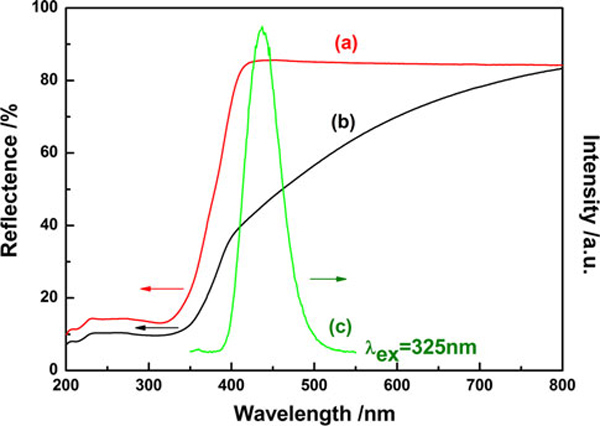
Overlap of diffuse reflectance spectra of a undoped TiO2(P25) and b TiO2-xNy and c emission spectrum of CaAl2O4:(Eu, Nd).